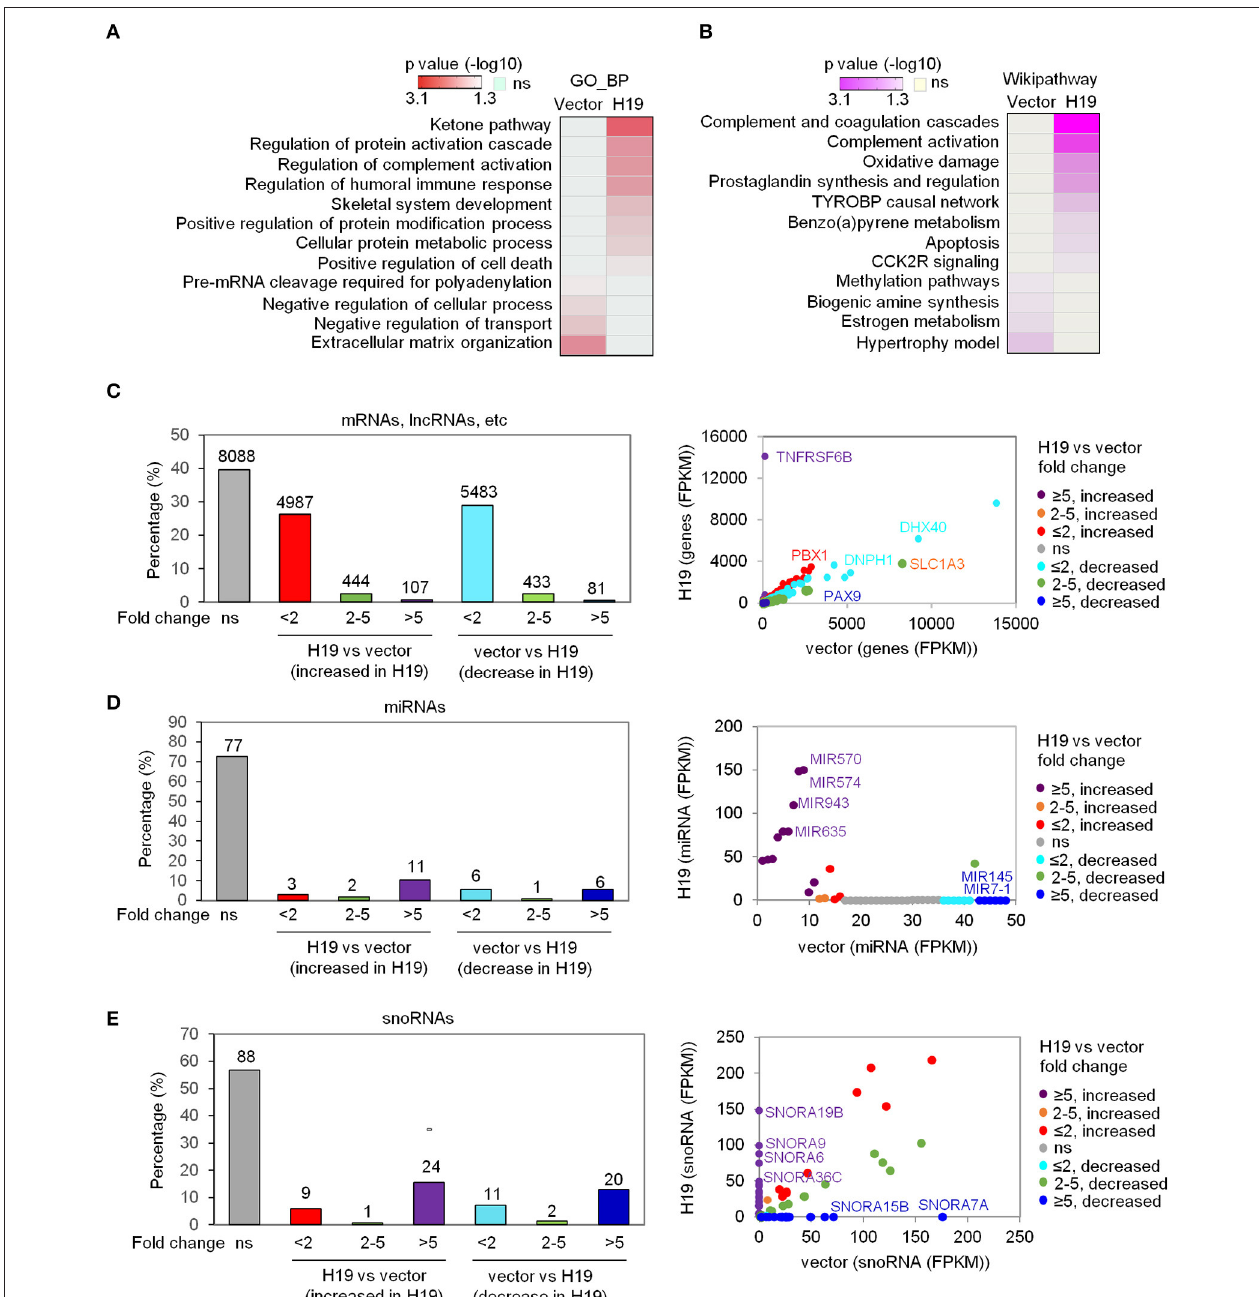
FIGURE 1 | H19 significantly affects miRNA and snoRNA expression. (A,B) Heatmaps show the GO_BP (A) and Wikipathway (B) categories enriched in either H19-expressing LFS osteoblasts (right column) or vector control LFS osteoblasts (left column) compared with each other based on mRNA expression of respective samples. Colors represent p values of enrichment. (C-E) H19 overexpression induces small changes in overall mRNA expression but large changes in miRNA and snoRNA expression in LFS osteoblasts. The percentage of mRNAs, lncRNAs, etc. (C) , miRNAs (D) , and snoRNAs (E) with different fold-changes ( < 2, 2-5, and > 5 increase or decrease) are shown in bar plots. RNA expression between H19-overexpressing and vector control cells is presented in a scatter plot (right). Dot colors are used to represent the fold change of RNA expression. ns (not significant) indicates mRNAs, lncRNAs, miRNAs, snoRNAs, etc. with fold-change < 2 and/or FPKM < 1. The RNA-seq experiment was done with one sample pooled from 3 biological replicates. miRNAs and snoRNAs are defined based on the miRbase and snoDB database, respectively. “mRNA, lncRNA, etc.” indicates all transcripts except miRNAs and snoRNAs.